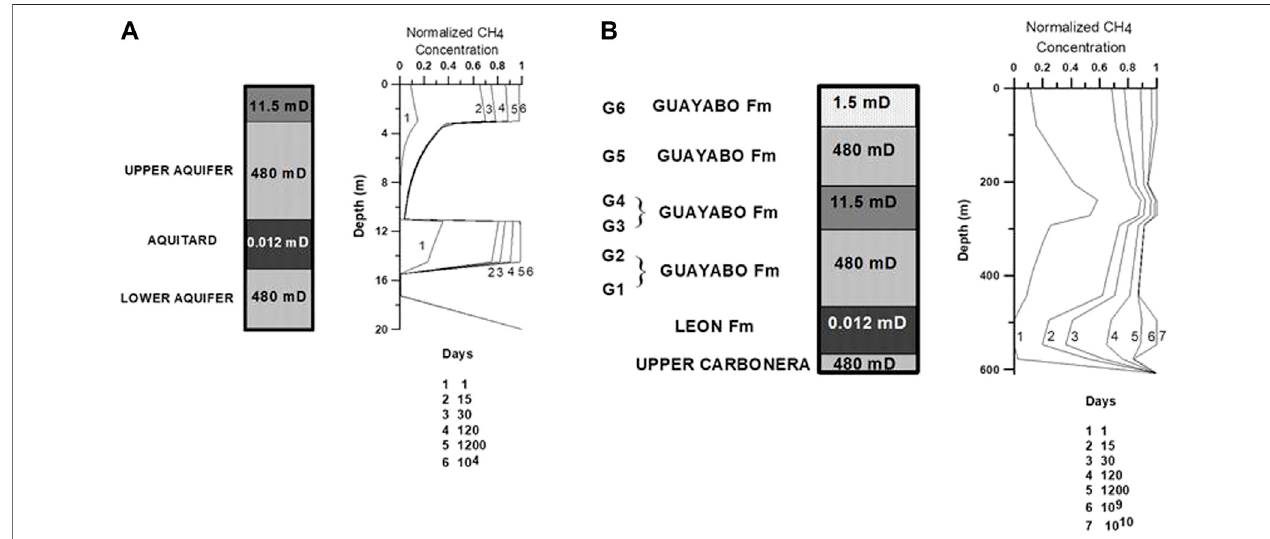
FIGURE 6 | Numerical predictions of the methane fractions variations versus depth for different times (indicated by days in the legends). The examples are for the control sequences (i.e., maximum permeability values and corresponding diffusion coef fi cients) of (A) borehole BH8 and (B) stratigraphic well Saltarin 1A.